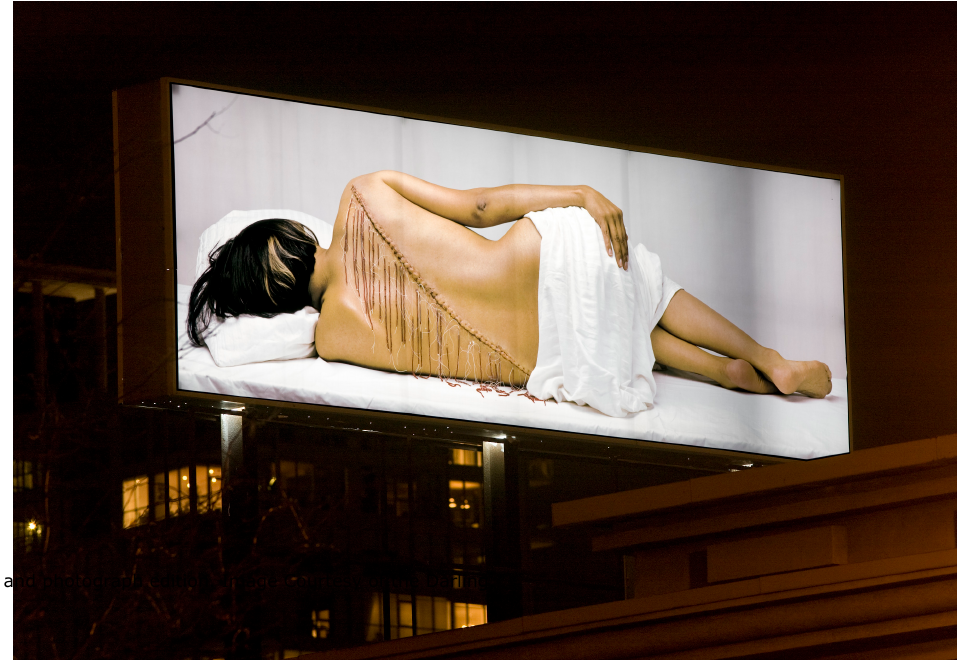
Rebecca Belmore, Fringe , 2008. Billboard, and photograph edition. Image Courtesy of the Darling Foundry Visual Arts